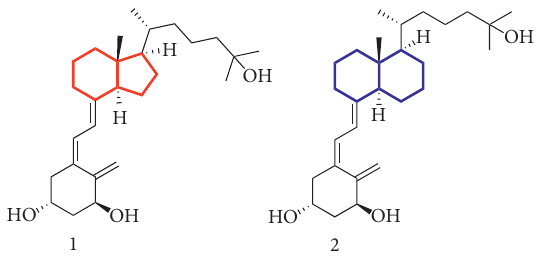
Figure 1: Structure of calcitriol 1 and trans -decalin vitamin D analogue 2.